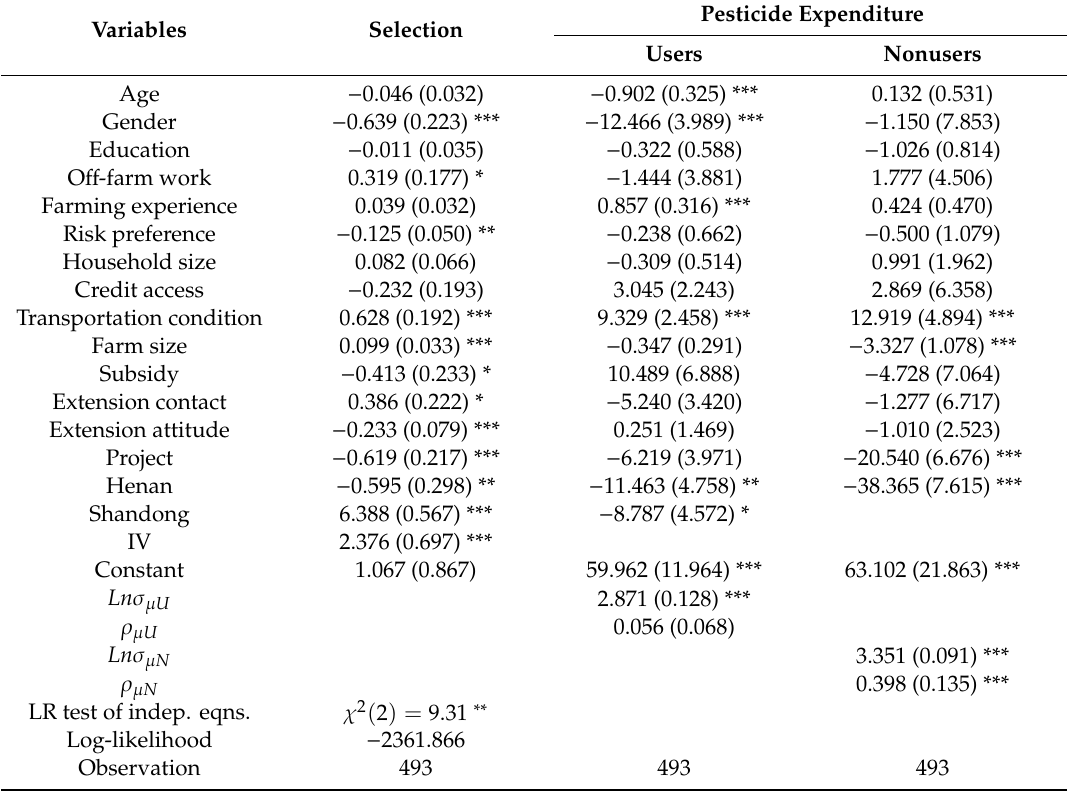
Table 3. Determinants of farm machine use and determinants of pesticide